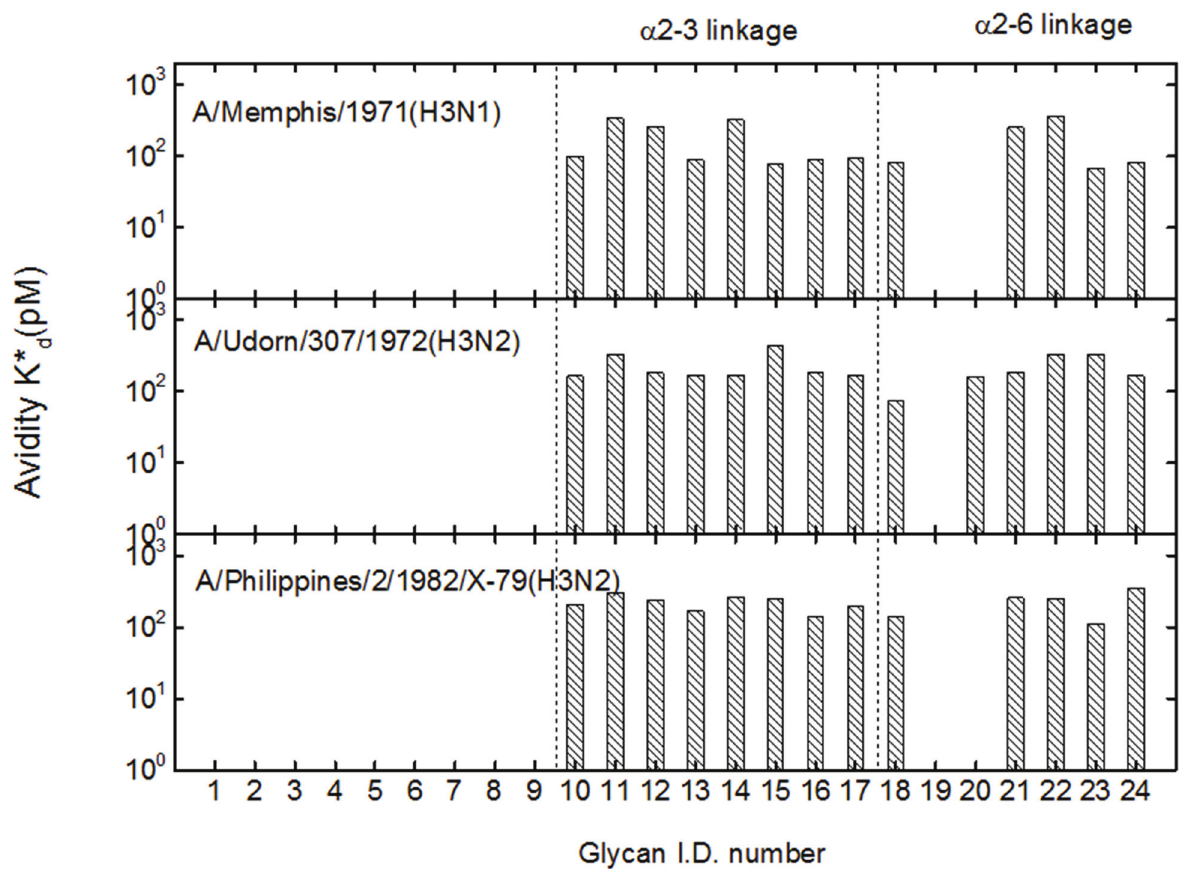
Figure 2. Avidity-enhanced equilibrium dissociation constants of three H3-subtype influenza viruses, A/Mem71 (top panel), A/Udorn72 (middle panel) and A/Philips (bottom panel),